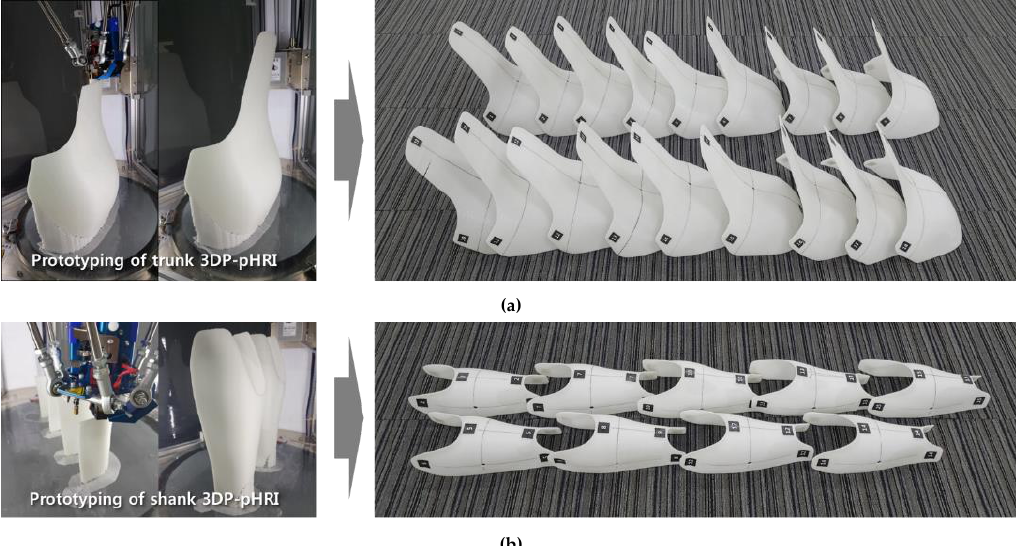
Figure 10. Results of 3DP-pHRI 3D printing: ( a ) 18 trunk 3DP-pHRI 3D printing and ( b ) nine shank 3DP-pHRI 3D printing results.